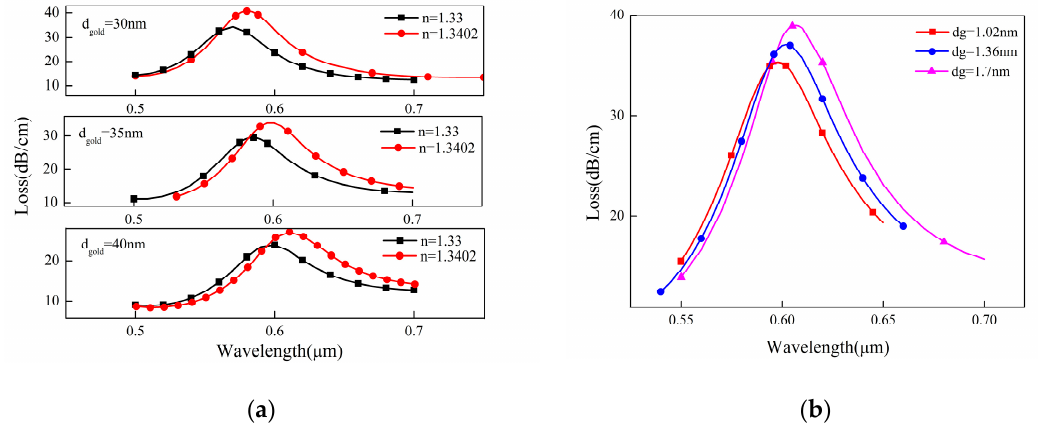
Figure 3. The influence of the gold film and graphene thickness. ( a ) The effect of the gold film thickness on photonic crystal fiber (PCF) confinement loss; ( b ) The effect of graphene thickness on PCF confinement loss.